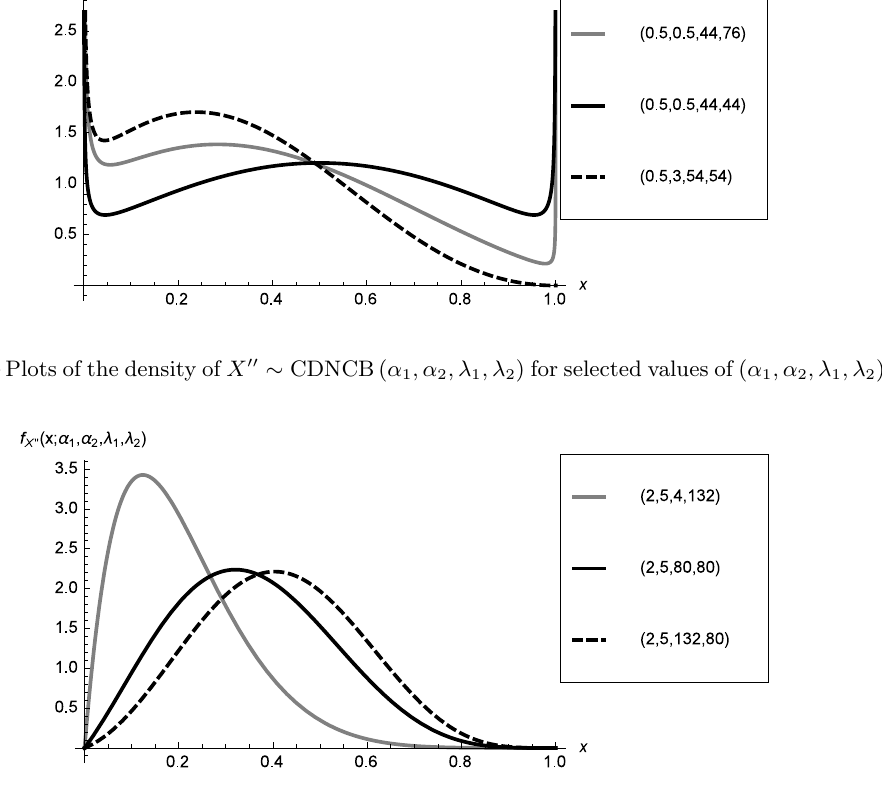
and the CDNCB are entirely due to differences between M + , which has a Poisson( (cid:21) + =